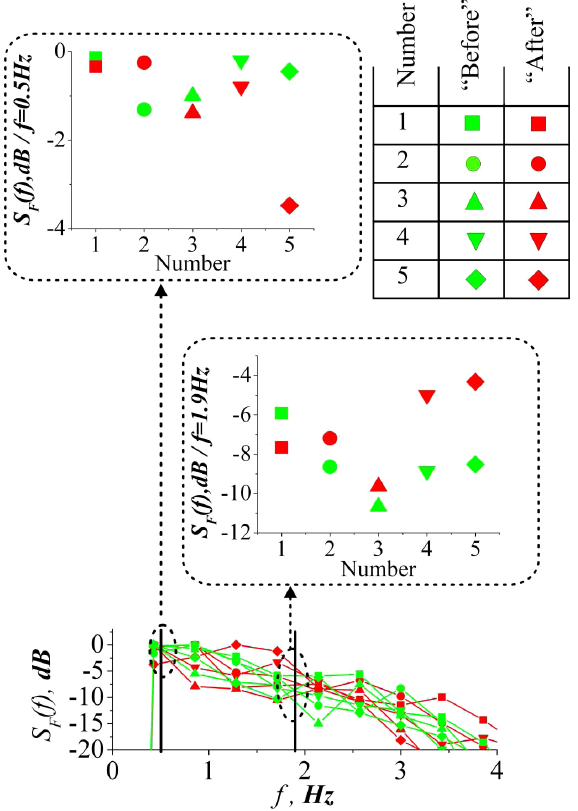
Fig. 5. Results of the classical spectral analysis. Green and red colors mark the dynamics in basic state and after the admin- istration of adrenaline,